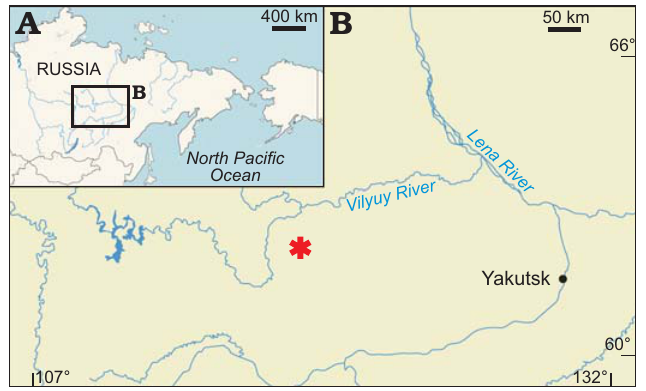
Fig. 1. A , B . Maps showing the geographic location of the Lower Creta- ceous Teete locality (asterisk) in Eastern Siberia,